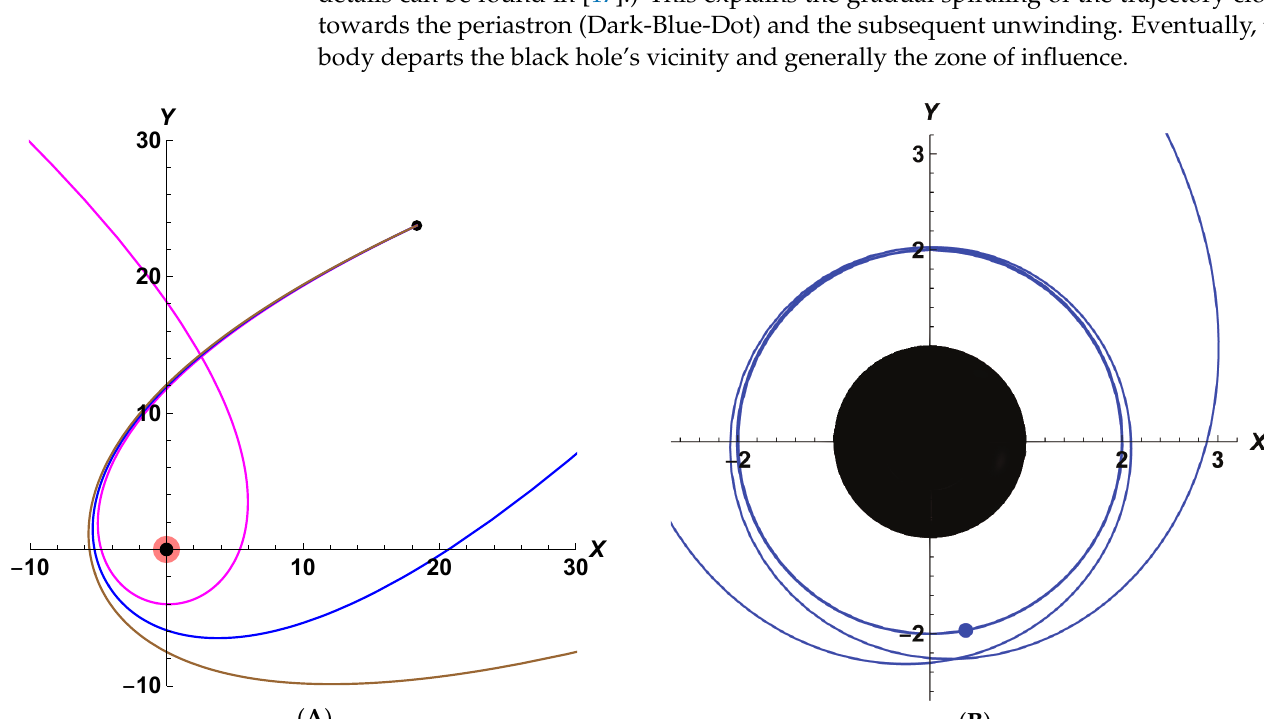
Figure 1. Trajectory distortions for an object traveling with initial angular momentum j in the vicinity of a black hole (BH) with “rotation rapidity” ω : ω > 0 when BH spin and momentum j are co-aligned, BH spin is counter-clockwise; ω < 0 when BH spin and momentum j are counter-aligned, BH spin is clockwise. When ω = ± 0.5, BH “radius” is 0.5 (in the equatorial plane θ = π /2) and ergosphere “radius” (pink) is 1. (Left Panel ( A )) Impact of BH spin direction ω is shown for: j = 2.5, ω = − 0.5 (brown); j = 2.5, ω = 0 (blue); j = 2.5, ω = 0.5 (magenta). (Right Panel ( B )) Dark-blue-trajectory (for ω = 0) illustrates temporary “capture onto quasi-circular orbit”: spiraling inward, passing through the periastron (Dark-Blue-Dot), and spiraling